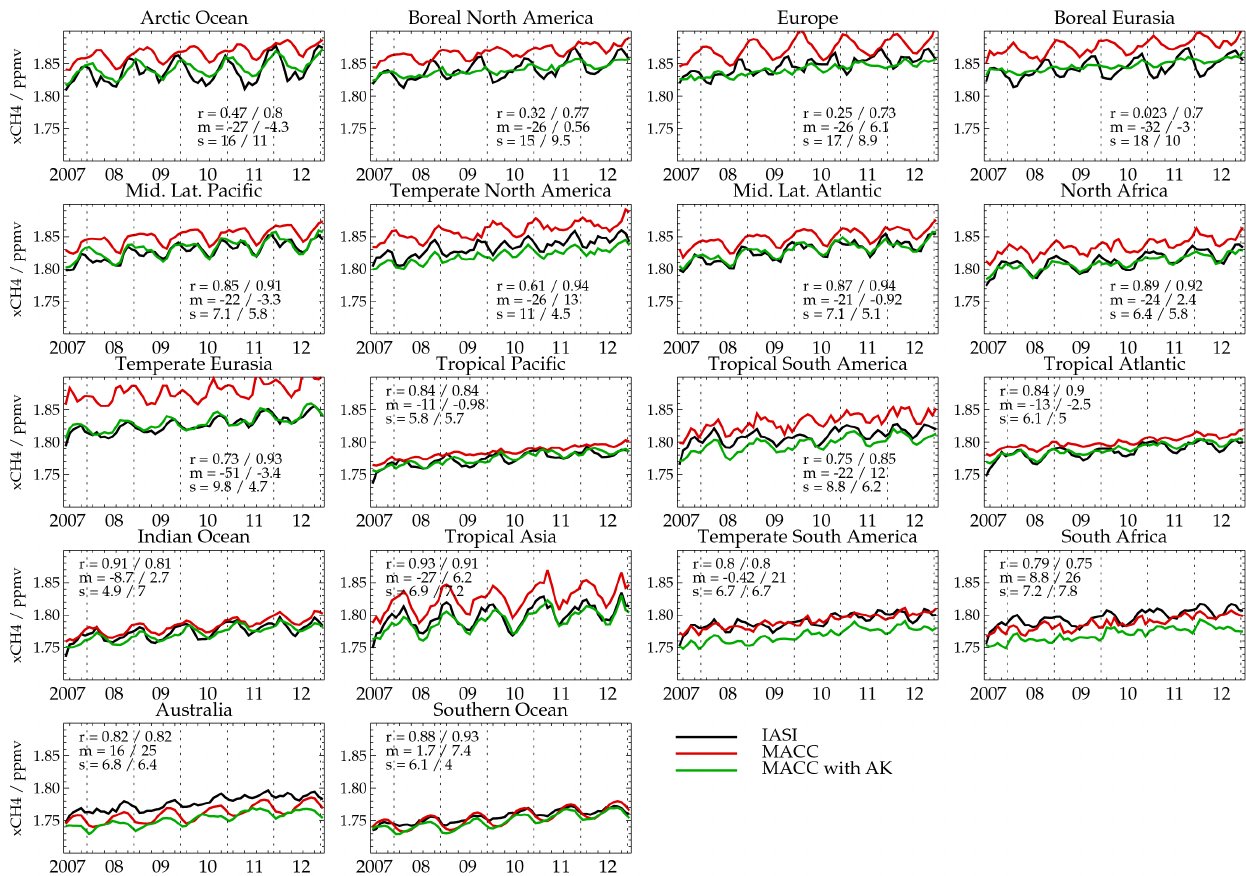
Figure 11. As previous figure but for 0–6km layer-averaged